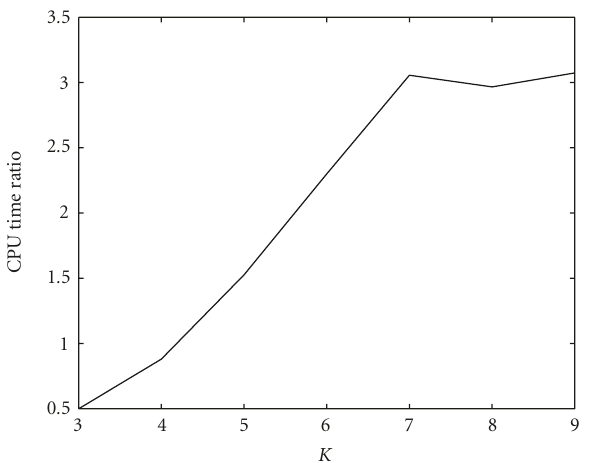
Figure 9: CPU time ratio of Wu and Barba’s method to the pro- posed approach.